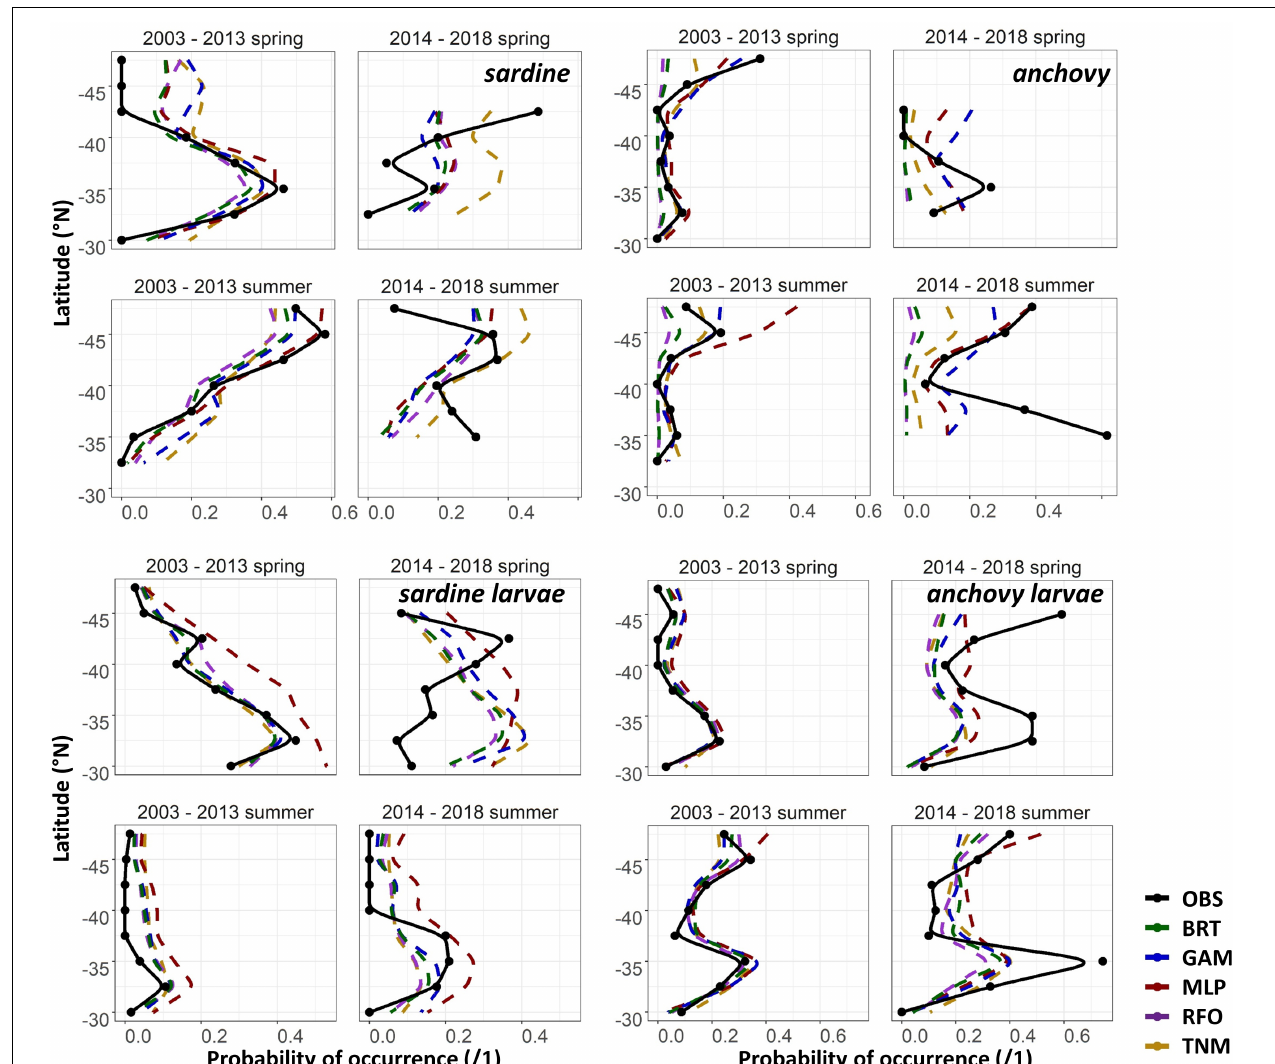
FIGURE 7 | Mean observed (black) and SDM predicted (colors) probabilities of occurrence of each life stage of each species in spring (April–May) and summer (July–August) by 2 ◦ latitude bins, for the test (2003–2013) and validation (2014–2018) time periods for Experiment